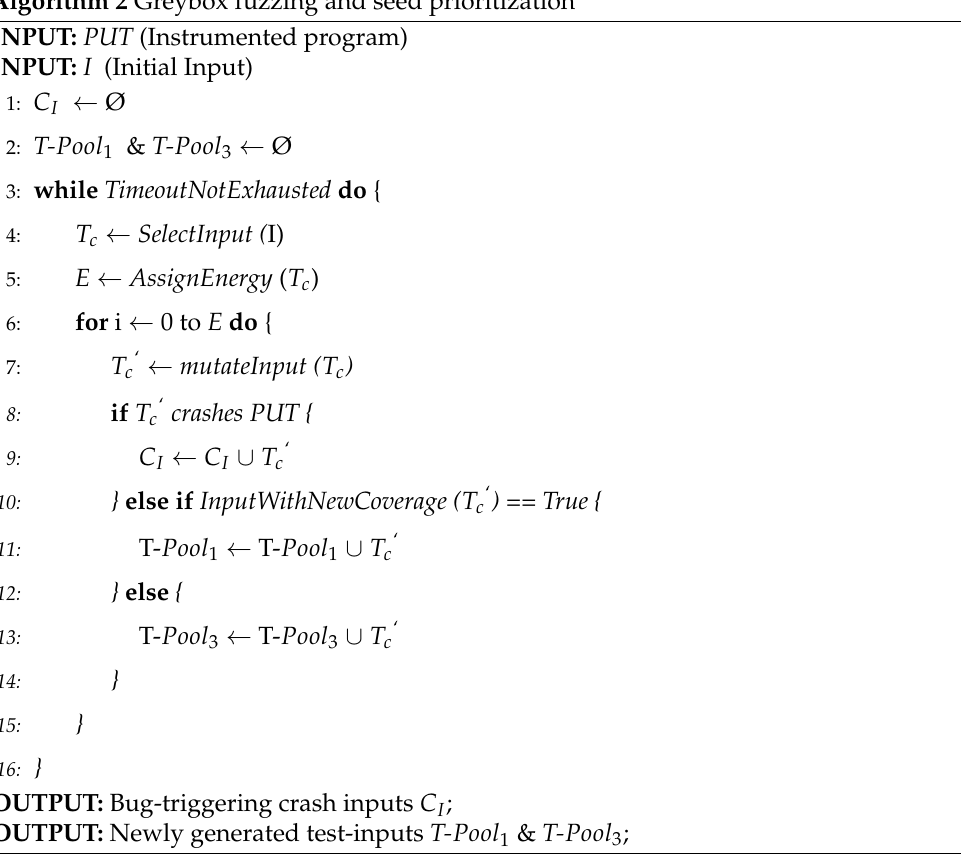
Algorithm 2 Greybox fuzzing and seed